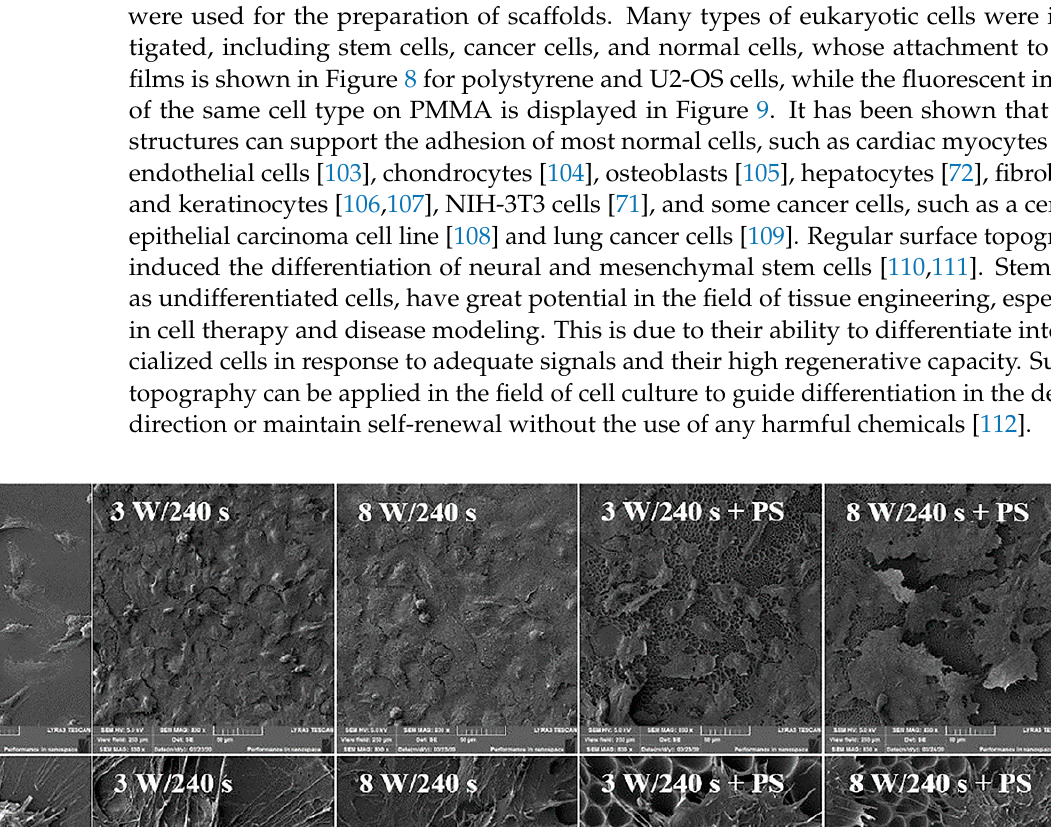
Figure 9. Fluorescence microscopy images of VAMPIRO U-2 OS cells (human cells derived from osteosarcoma, stably transfected with tFP602) growing on pristine fluorinated ethylene propylene (FEP) and FEP treated with 8 W plasma for 240 s and subsequently coated with a honeycomb-like pattern formed from polymethyl methacrylate (PMMA) solution (1 g), 24 h and 96 h post-seeding, respectively. Scale bar represents 20 microns [24]. 6.2. Drug Delivery Not only can structured films, thanks to their topography, control the “fate” of cells, they can also release therapeutics in a controlled manner into the surrounding medium (or into cells cultured on the material) or create reservoirs for various drug-delivery sys- tems [113]. Due to its large specific surface area, the porous surface can accommodate a larger amount of therapeutics, even drugs with low solubility, which can be well dis- persed in hydrophobic polymer matrices [114]. In addition, studies have shown that the encapsulation of drugs in porous layers contributes to a reduction in the so-called “burst release”, the negative effects of which are pharmacologically dangerous and economically inefficient [115]. Due to the highly porous nature of HCP films, the release characteristics